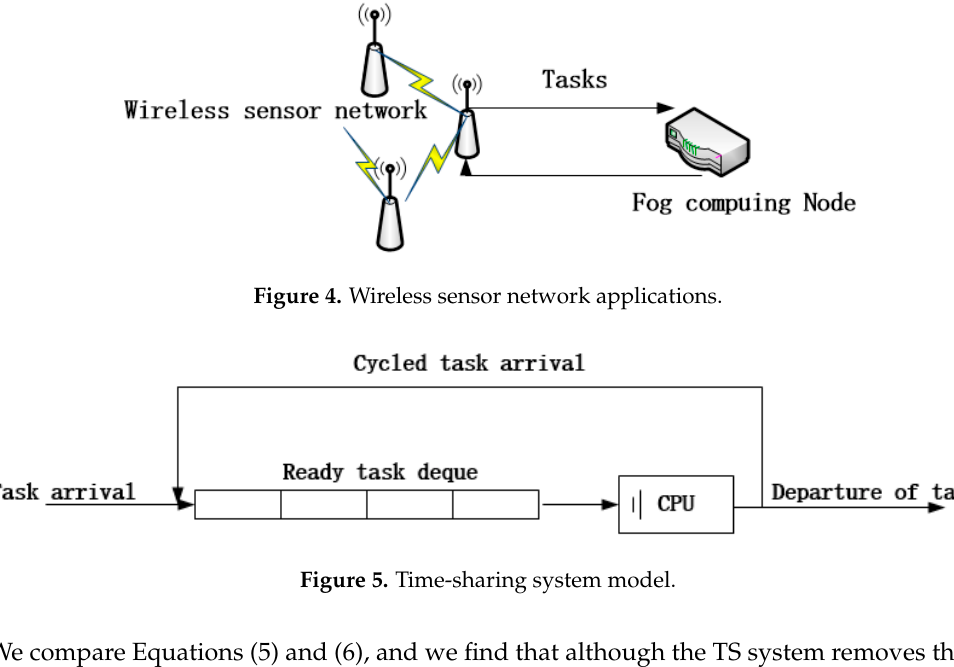
Figure 5. Time-sharing system model.